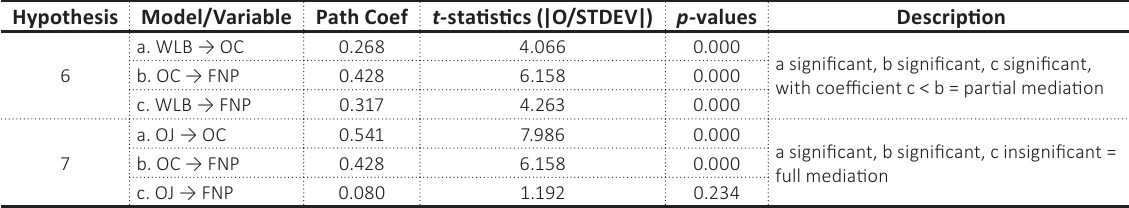
Source: The result of data processing from